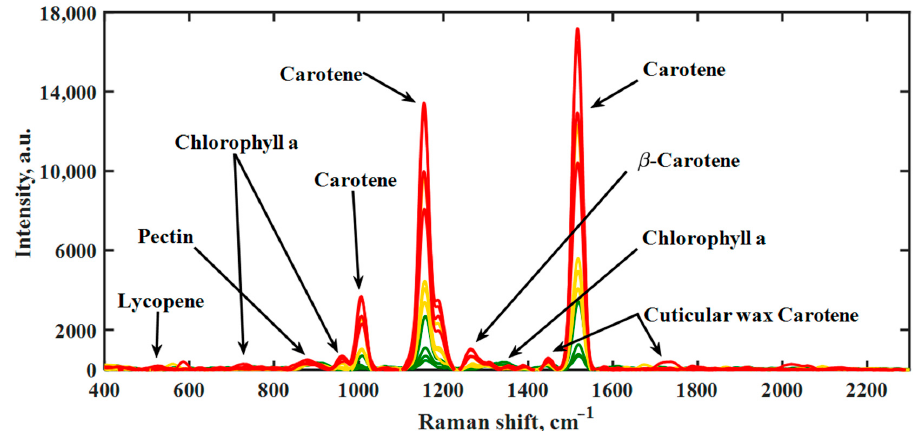
Figure 1. Raman spectra of hot peppers during the maturation process obtained with handheld Raman spectrometer at 785 nm laser wavelength [13,23,31]. Unripe pepper (green), ripening pepper (yellow) and fully ripe fruit (red) are each represented by four deliberately selected